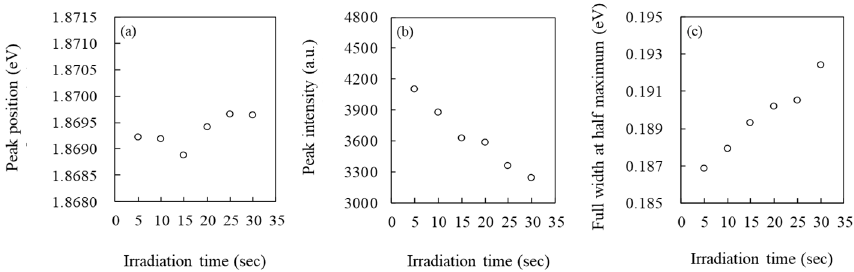
Figure 5. The relationships between EB irradiation time and CL spectral parameters; ( a ) peak position, ( b ) peak intensity, and ( c ) FWHM.